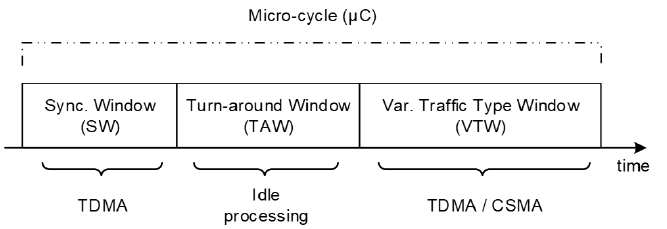
Figure 5. Micro-cycles (µC) structure